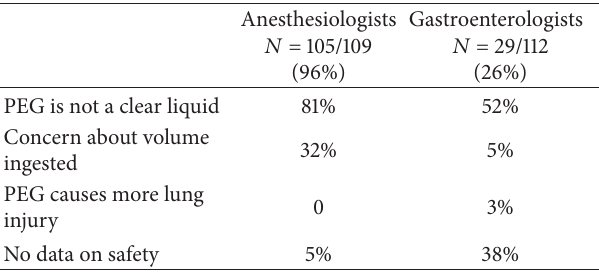
Table 2: Reasons given by respondents for waiting > 2